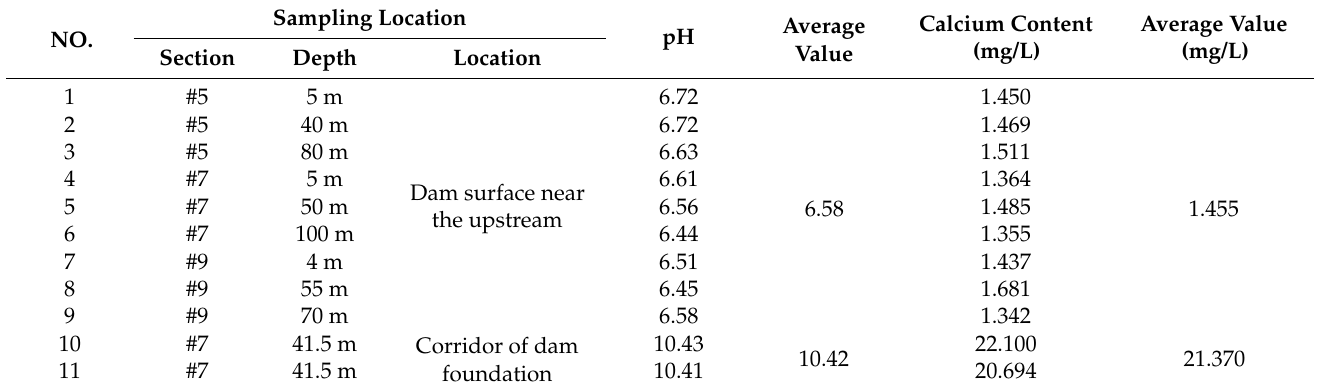
Table 2. Results of upstream and corridor water